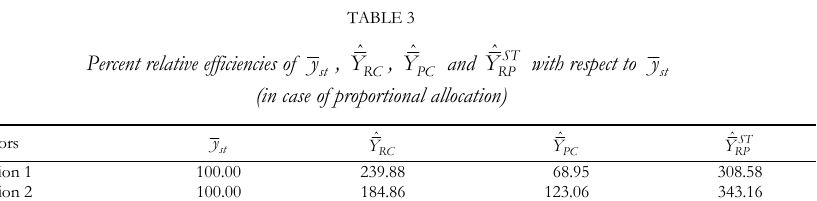
Percent relative efficiencies of